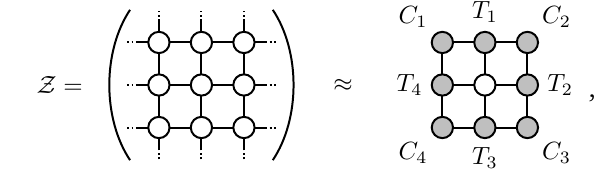
Figure 1: Decay of the Bessel functions I (cid:96) + of the angular momentum (cid:96) , for several values of the inverse temperature β = 1 / T